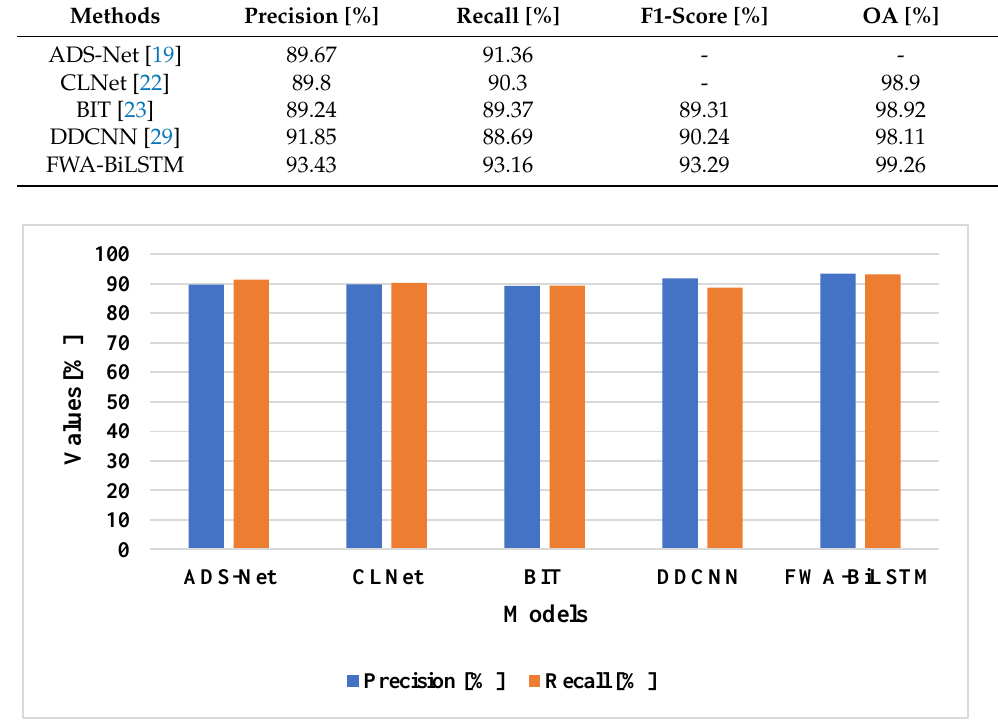
Figure 12. Comparative analysis of the LEVIR-CD dataset.